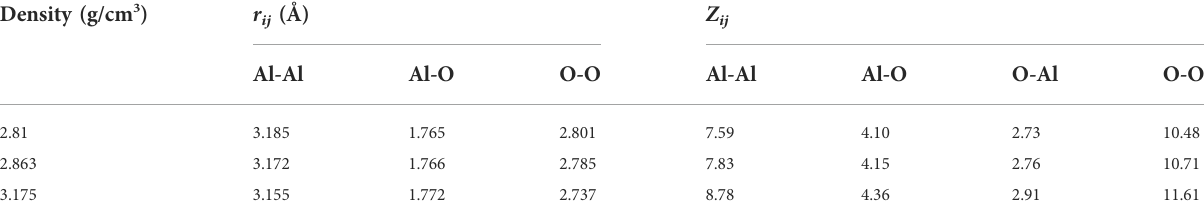
TABLE 4 Structural characteristics of liquid alumina at 2500 K and three densities. r ij -positions of the fi rst peaks in partial pair distribution functions; Z ij -the average coordination number. Density (g/cm 3 )